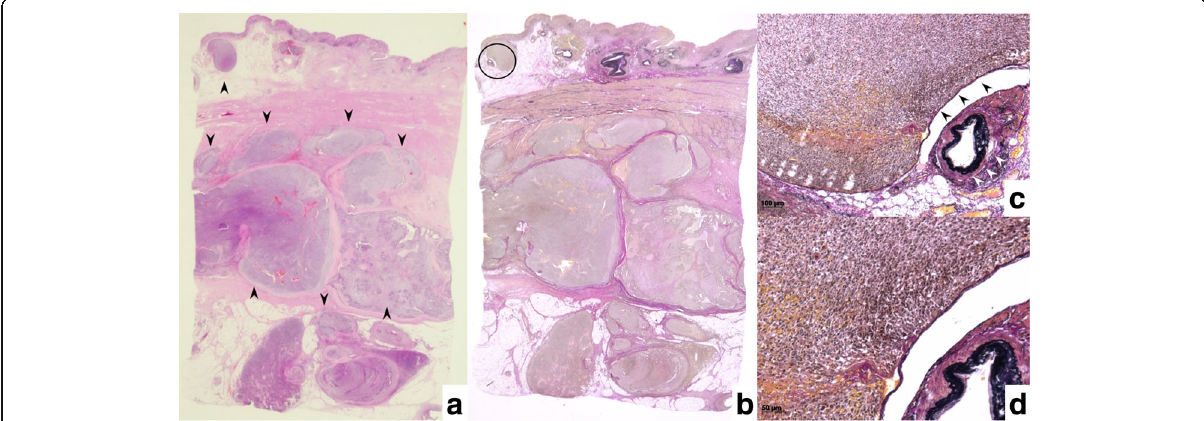
Fig. 3 Macroscopic pathology findings. a , b The tumor cells were mainly found intravenously inside and outside of the stomach wall (black arrowhead) and were not found in the gastric wall stroma. a Hematoxylin-eosin stain, original magnification. b Elastic van Gieson staining, original magnification. c , d These are pictures enlarged with a circle on b . The tumor cells existed in venous (black arrowhead) locations and could be identified among the elastic fibers of veins and nearby arteries (white arrowhead). c Elastic van Gieson staining, original magnification × 50.